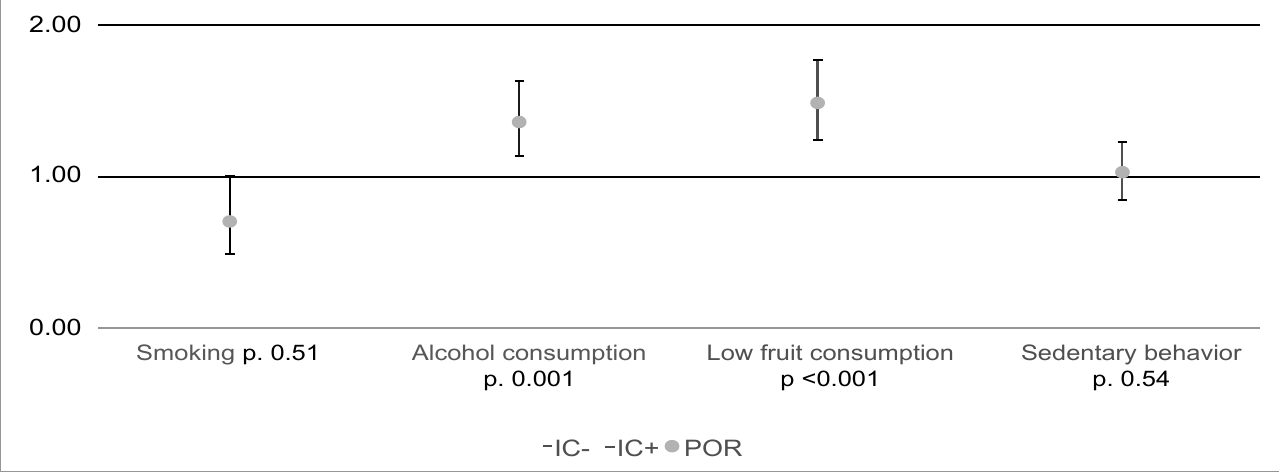
Figure 1. Prevalence Odds Ratio (POR) for insufficient level Note. CI=95% confidence interval. "Smoking” was defined as having any amount of cigarettes in the past 30 days; “alcohol consumption” was defined as consuming alcoholic beverages; “ low fruit consumption ” was defined as consuming less than three servings of fruits per day; and “ sedentary behavior ” was defined as spending two hours or more per day in activities in the seated